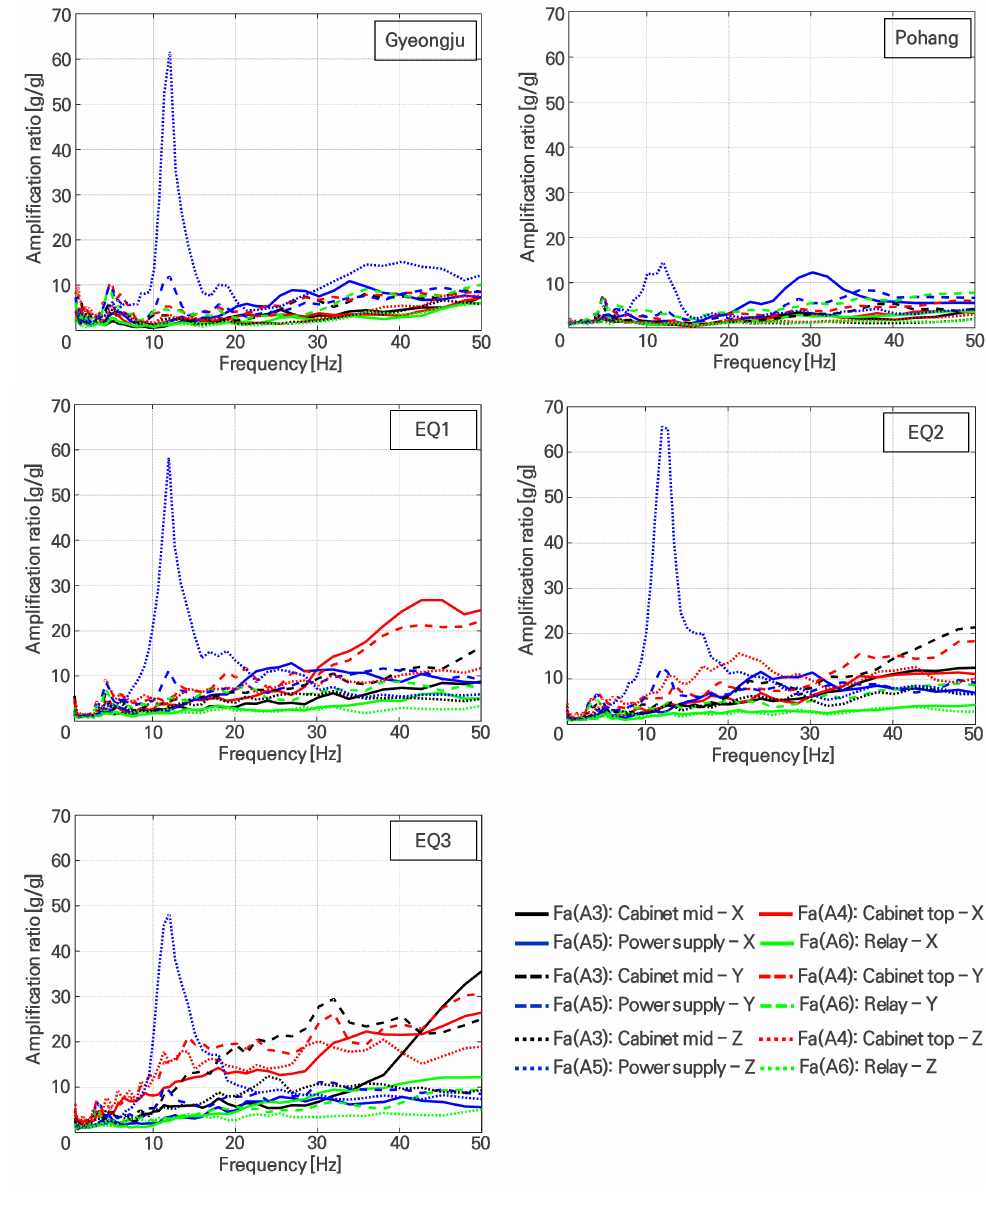
Figure 14. F a values for Case 1.